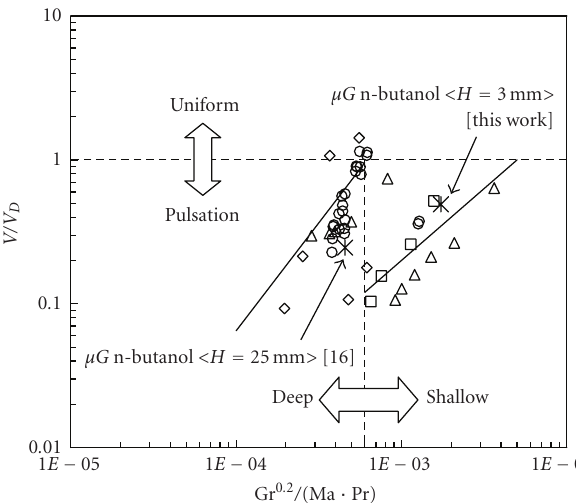
Figure 10: Flame spread rate as a function of for four di ff erent alcohols ( (cid:8) methanol: H = 1–10 mm; (cid:4) ethanol: H = 1–5mm; (cid:9) n-pripanol: H = 2–20 mm; ◦ n-butanol: H = 1–50 mm).